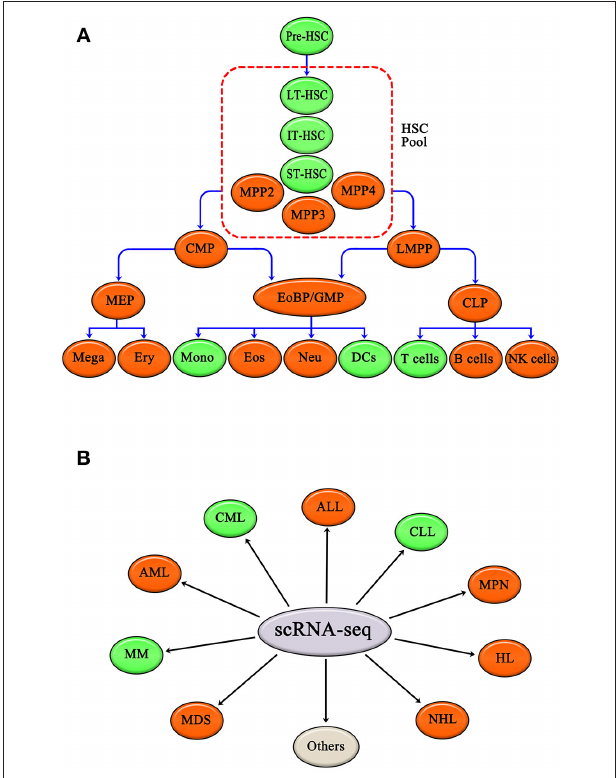
FIGURE 2 | Normal hematopoietic cells and malignant hematopoiesis have been studied by single cell RNA-seq. (A) Single cell RNA-seq applied to hematopoietic cells, such as HSC, DCs, Mono, and T cells. Other hematopoietic cells, like CMP, GMP, MEP, LMPP, CLP, Mega, Ery, Eos, Neu, B cells, and NK cells, are also expected to be researched. (B) Single cell RNA-seq has been applied in CML, CLL, and MM. Single cell RNA-seq is expected to be applied to other hematopoietic malignancies as well, including AML, ALL, MPN, HL, NHL, and MDS. Green ovals show normal hematopoietic cells and malignant hematopoiesis that have already been studied by single cell RNA-seq, and red ovals show hematopoietic cells and